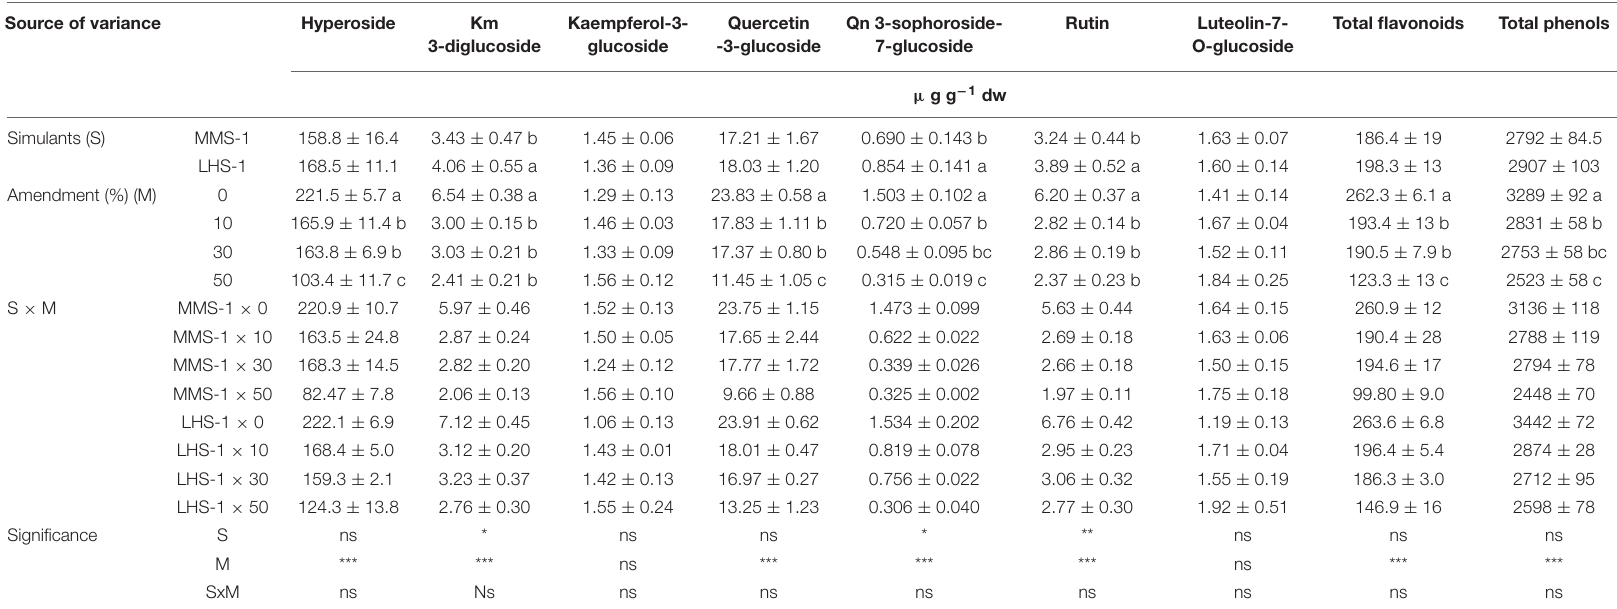
TABLE 3B | Phenolic profiles and total phenolic composition of lettuce grown in different mixtures of MMS-1 or LHS-1 simulants and manure (simulant/manure rates: 100:0, 90:10, 70:30, 50:50; w/w). Source of